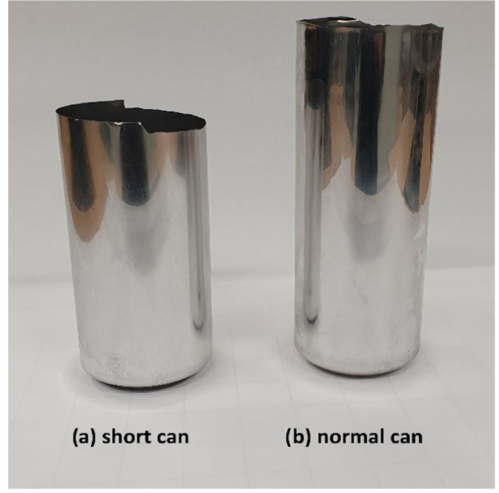
Figure 1. Analyzed defect—”short